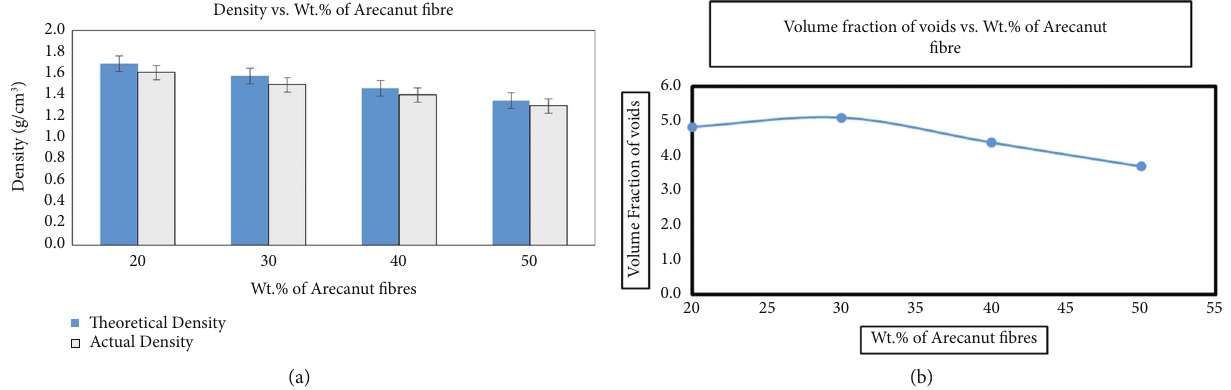
Figure 3: (a) Density vs. wt% of areca nut fi bers. (b) Volume fraction of voids vs. wt% of areca nut fi bers.